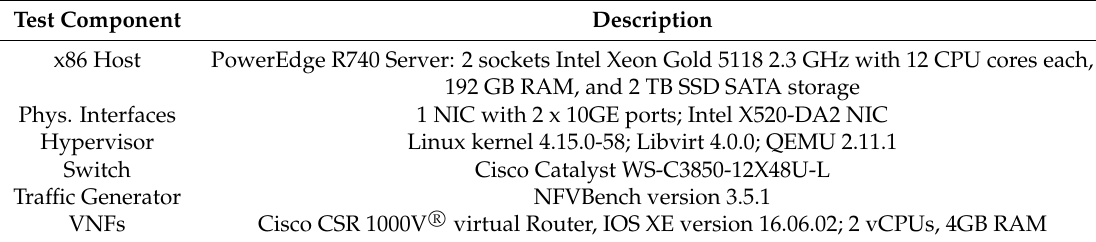
Table 1. Details of the experimentation